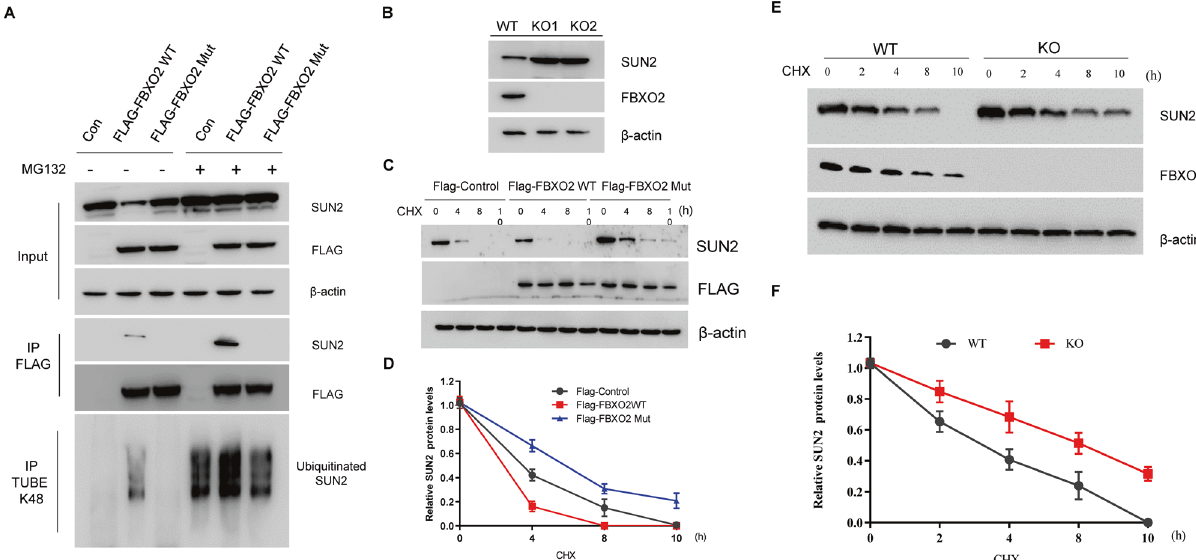
Fig. 5 FBXO2 targets glycosylated SUN2 for ubiquitination and degradation. A HEK293T cells were transfected with indicated plasmids. MG132 was added 4 h before harvest where indicated. Lysates were immunoprecipitated with anti-FLAG antibody or by Tandem Ubiquitin Binding Entity (K48 TUBE HF) and immunoblotted as indicated. B Western blot analysis of A2780 FBXO2 WT (FBXO2 + / + ) cells or A2780 FBXO2 KO (FBXO2 − / − ) cells. C HEK293T cells were transfected with indicated plasmids and then treated with 20 μ M CHX for the indicated time course. The cell lysates were examined by immunoblotting assay. D Statistic results of immunoblotting analysis from ( C ) were obtained by ImageJ software and were normalized to β -actin intensities, n = 3. E A2780 FBXO2 WT (FBXO2 + / + ) cells or A2780 FBXO2 KO (FBXO2 − / − ) cells were treated with Cycloheximide (CHX, 20 μ M) for the indicated time course. The cell lysates were examined by immunoblotting assay. F Statistic results of immunoblotting analysis from ( E